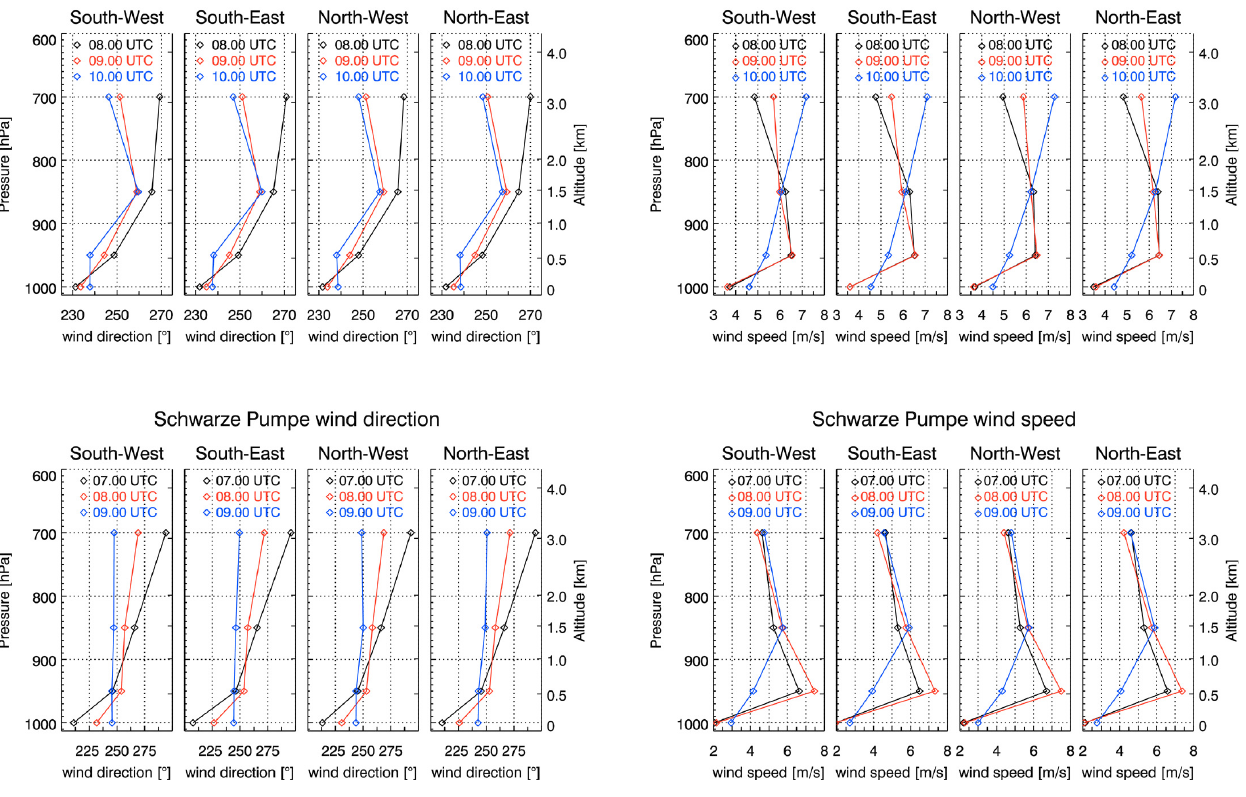
Fig. 4. Figure of wind directions at the sites of the four nearest neighbours of the power plants J¨anschwalde and Schwarze Pumpe according to the COSMO-DE model as used for the inversion process.